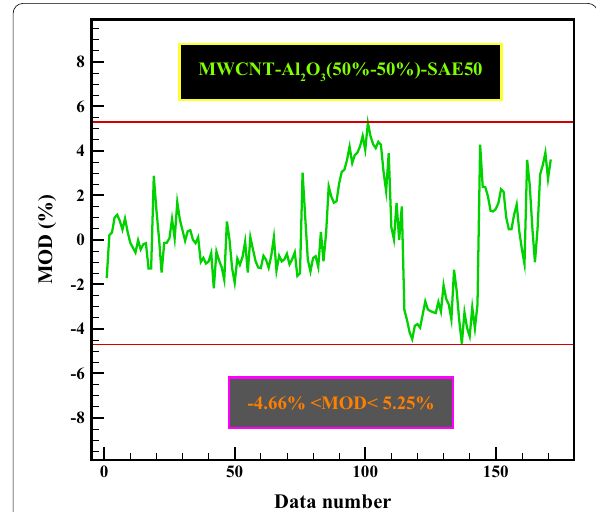
Fig. 12 Correlation of predicted data with actual data